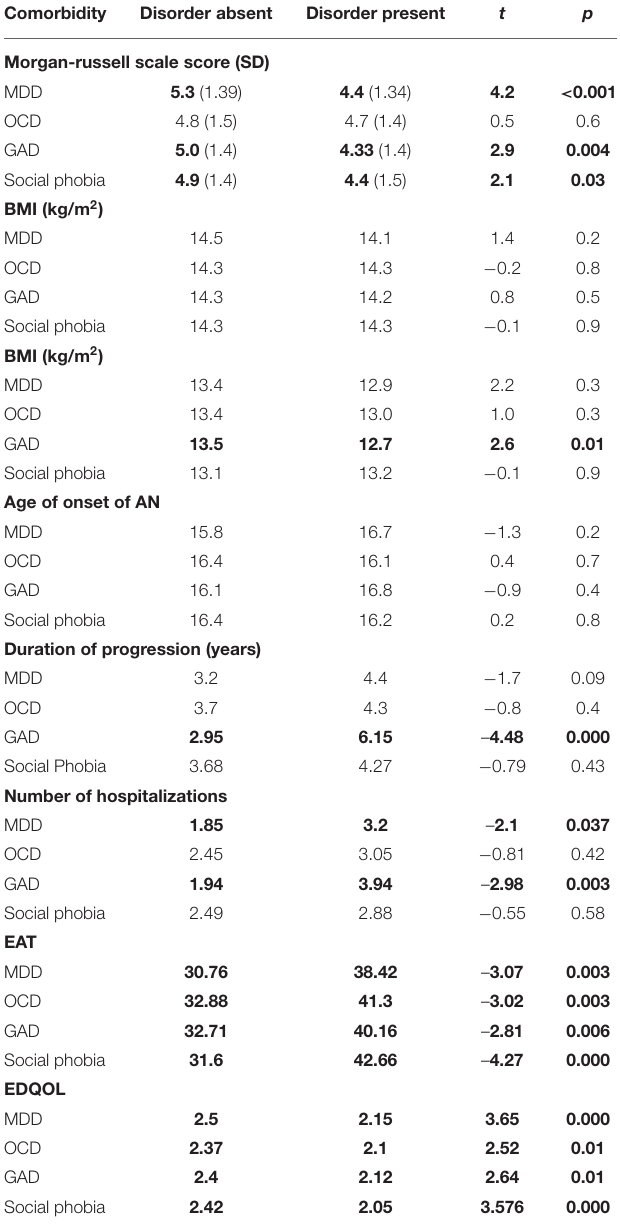
TABLE 3 | Comparison of average scores on clinical condition assessment scales according to the presence or absence of a comorbidity (per Student’s t -test).